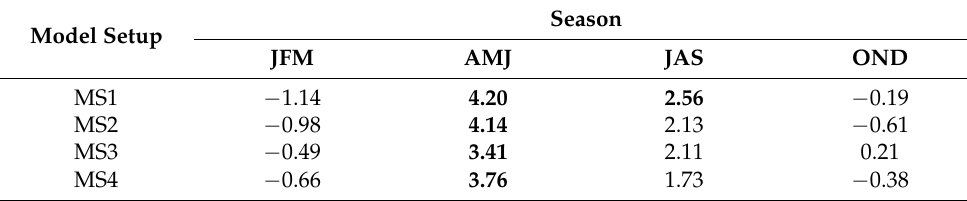
Table 1. Linear trends in the area of 10th-percentile soil drought (% of grid points per 10 years) in the 0–100 cm soil layer in the Czech Republic in JFM, AMJ, JAS, and OND in the 1961–2020 period according to four SoilClim model setups MS1–MS4. Statistically significant linear trends at a 0.05 significance level are in bold.